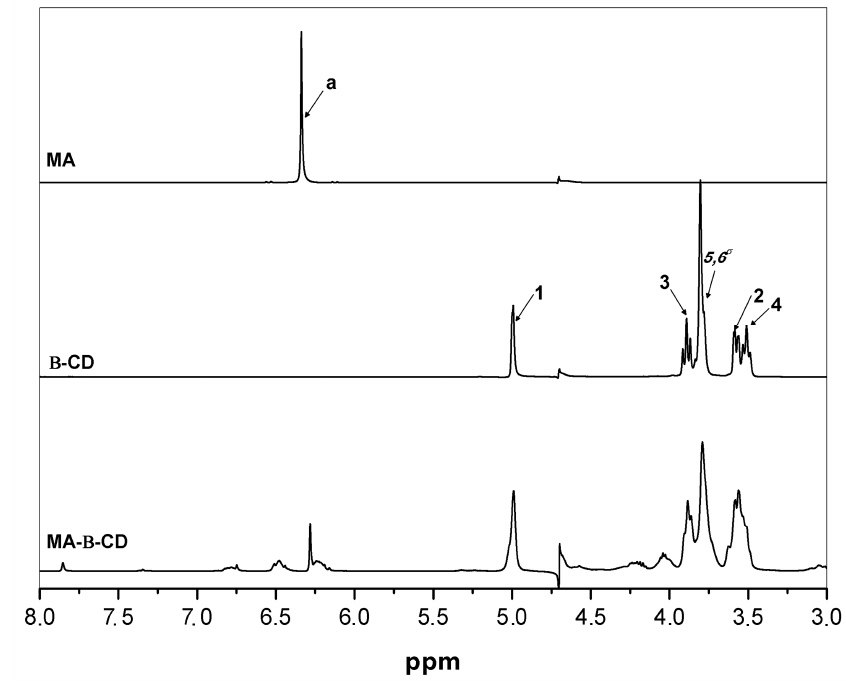
Figure 1. 1 H NMR spectra of MA, β -CD and MA- β -CD (from top to bottom) in D 2 O, 400 MHz.